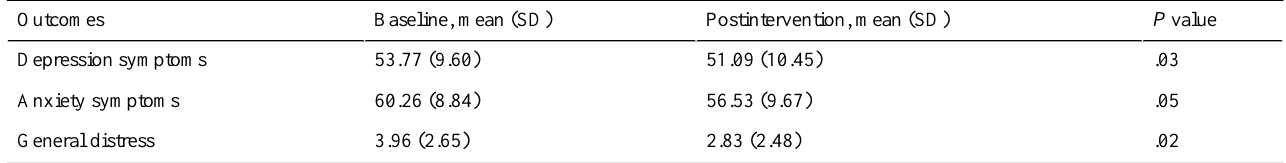
Table 2. Means and SDs of psychosocial outcomes at each time point, along with the results of paired t tests.